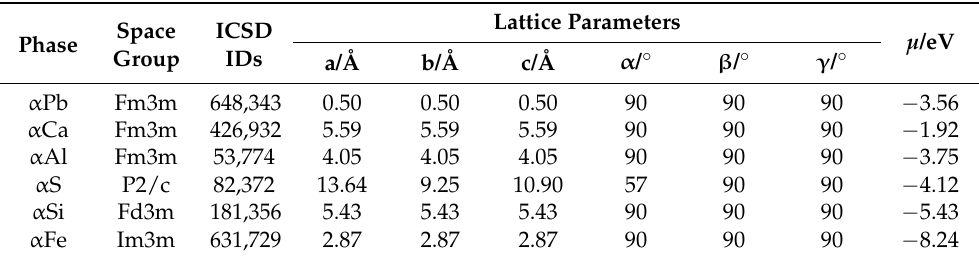
Table A2. Phases, space group, ICSD IDs, lattice parameters [36], and chemical potentials ( µ ) of Pb and the atoms that have been replaced by Pb.